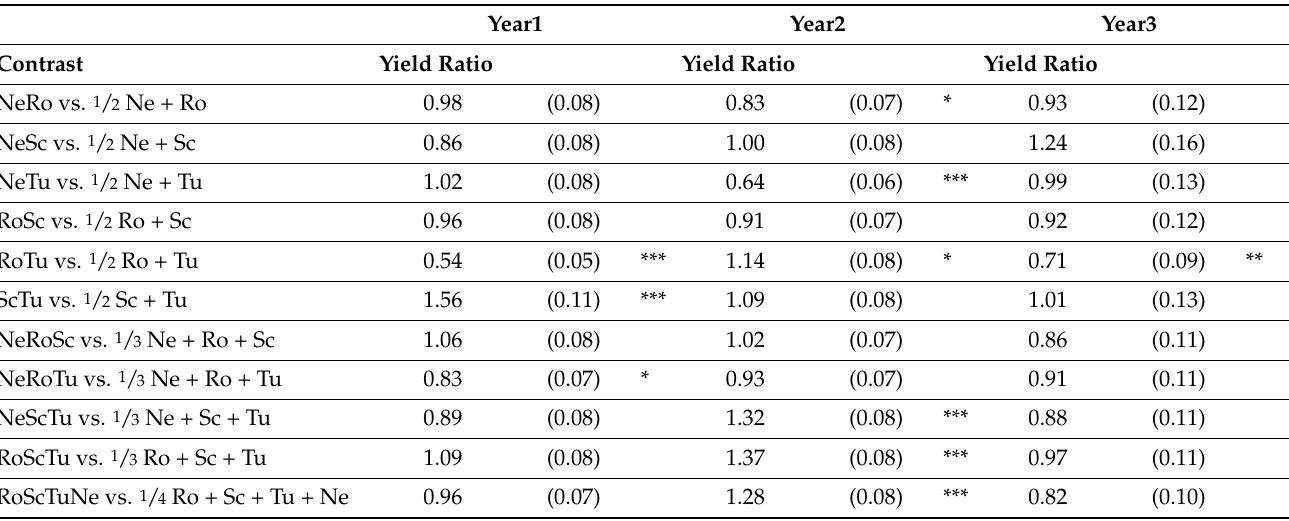
Values represent the ratio between the mixture yield and the average yield of the mixture components (S.E.). If the ratio is <1, the mixture performs worse than its components, and if it is >1, the mixture performs better than its components. * indicates statistical significance at p ≤ 0.05 level, ** at p ≤ 0.01, *** at p ≤ 0.001 (Estimated Marginal Means post hoc test) between the mixture yield and the average of its components. Ne = cv. Nera, Ro cv. = Robin, Sc = cv. Screziata, Tu = cv.